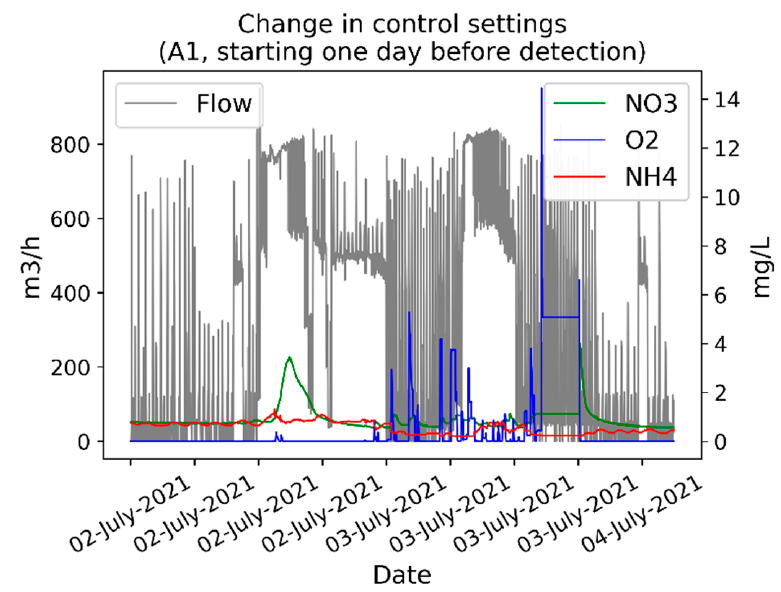
Figure 11. Example of an anomaly detected in WWTP3 PCT2. The anomaly is most likely caused by change in control settings.